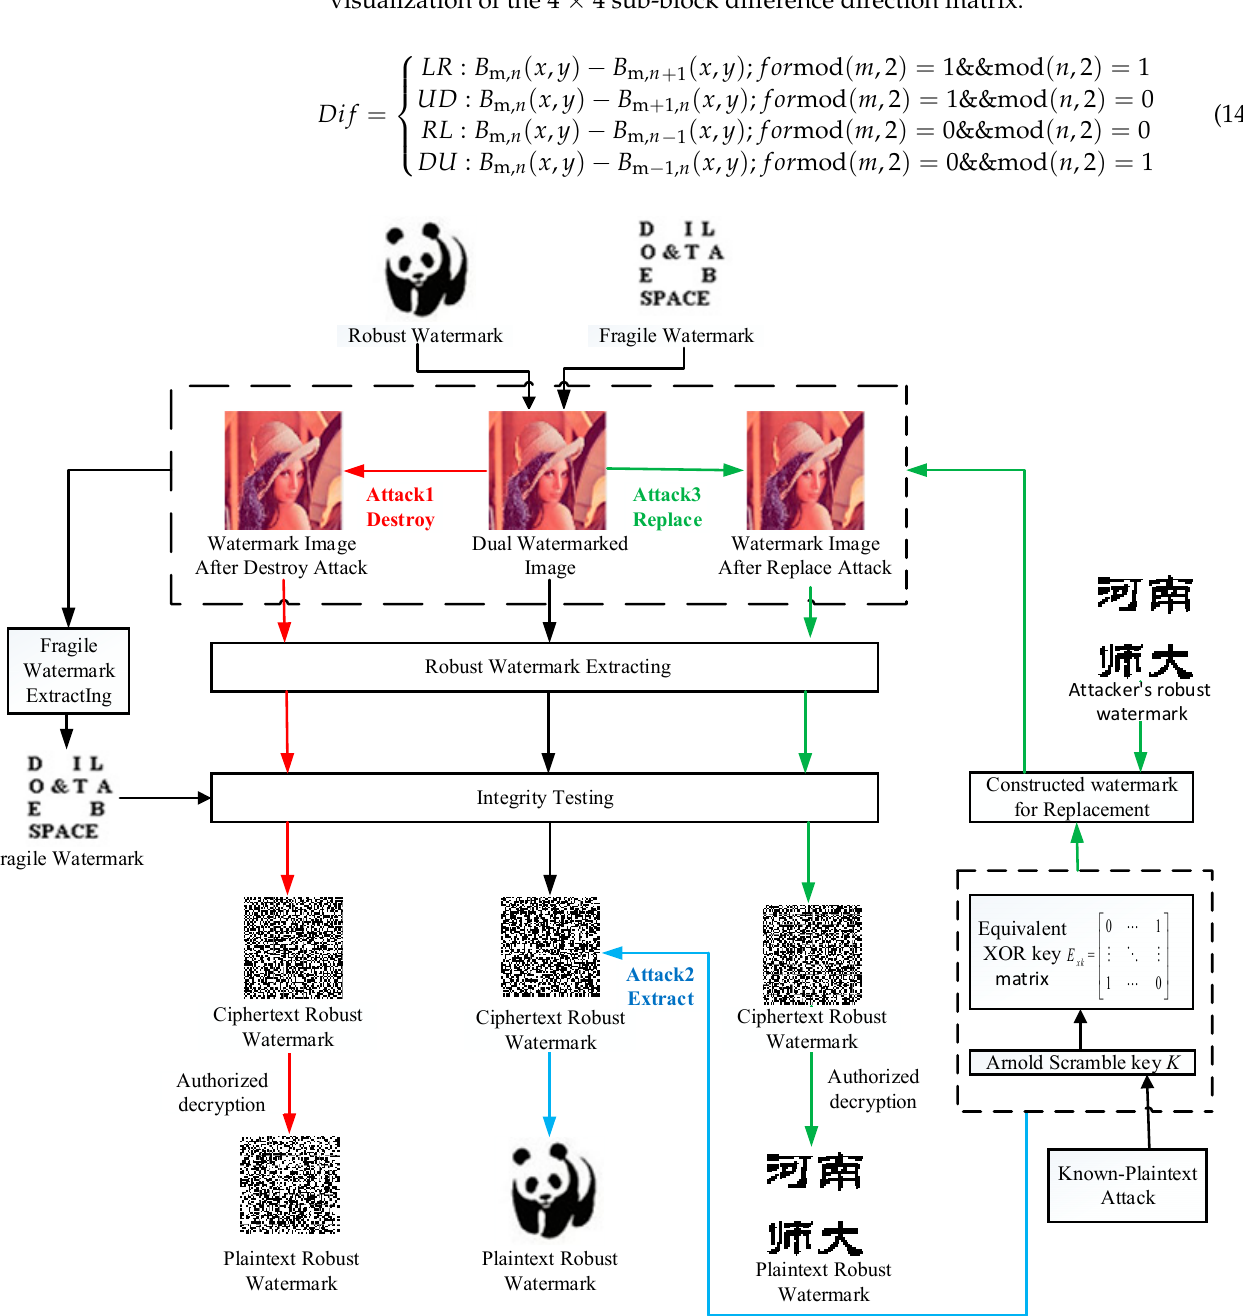
Figure 4. The a tt ack framework of the original dual watermark scheme. Figure 4. The attack framework of the original dual watermark